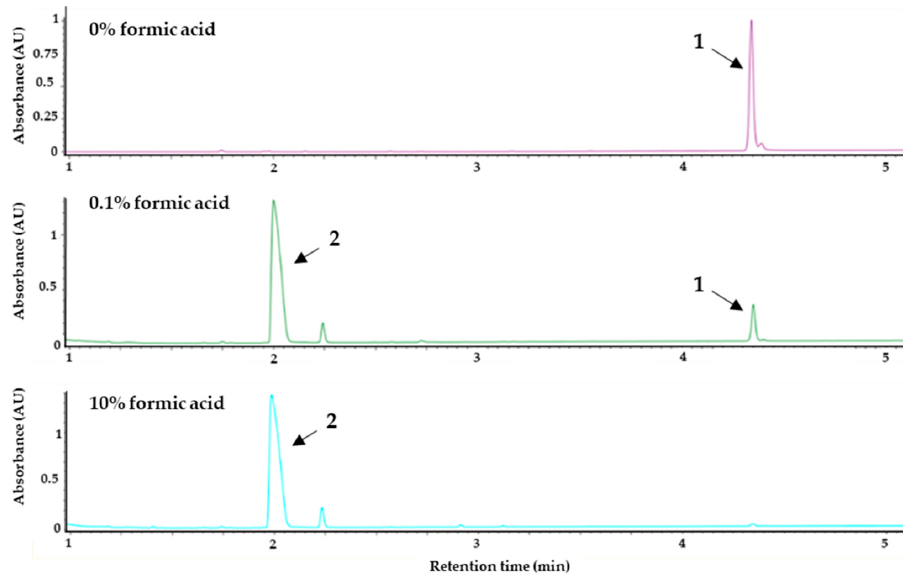
Figure 4. UV-max plot chromatogram. Degradation study showing the effect of formic acid on Figure4. UV-maxplotchromatogram.Degradationstudyshowingtheeffectofformicacidonserratiochelin